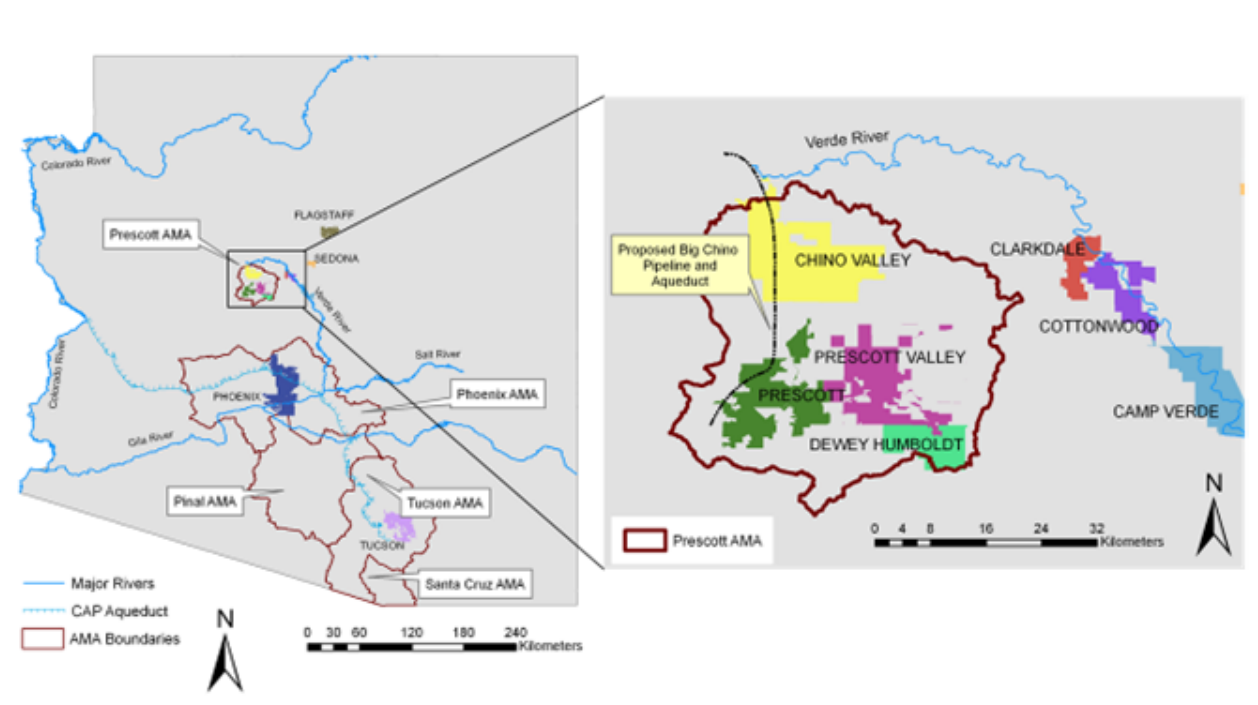
Fig. 1. Map of the case